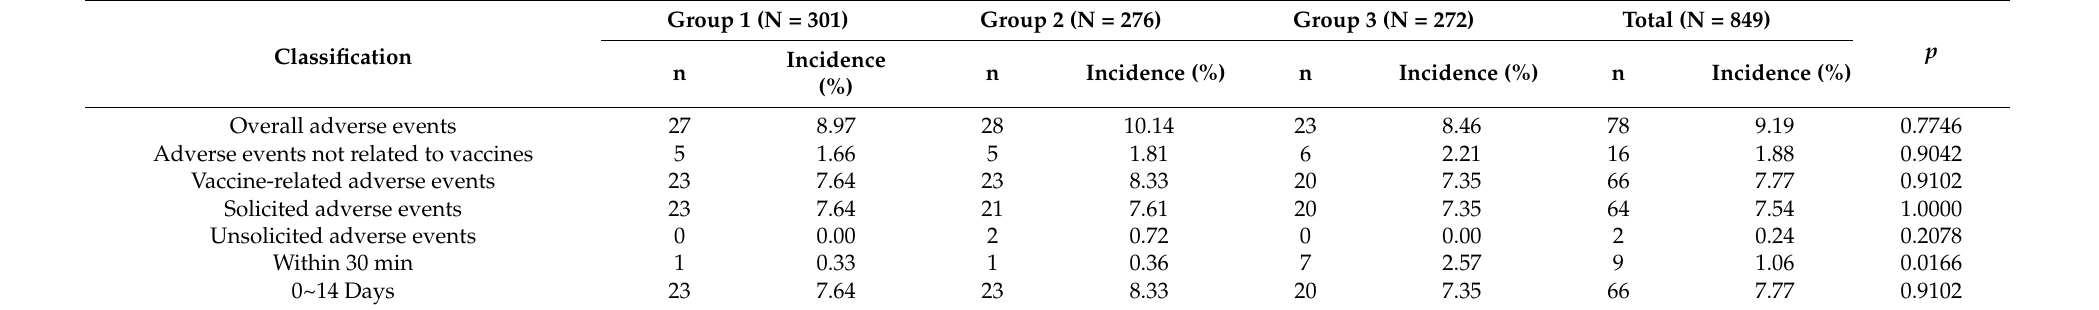
Table 4. The details of adverse events after booster